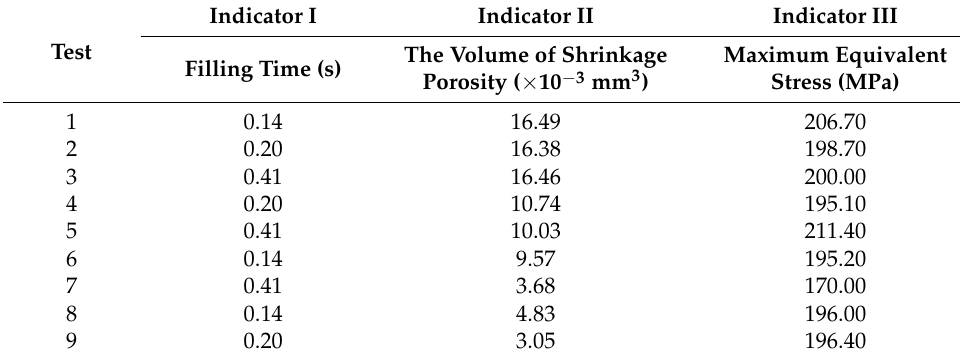
Table 3. The orthogonal experiment